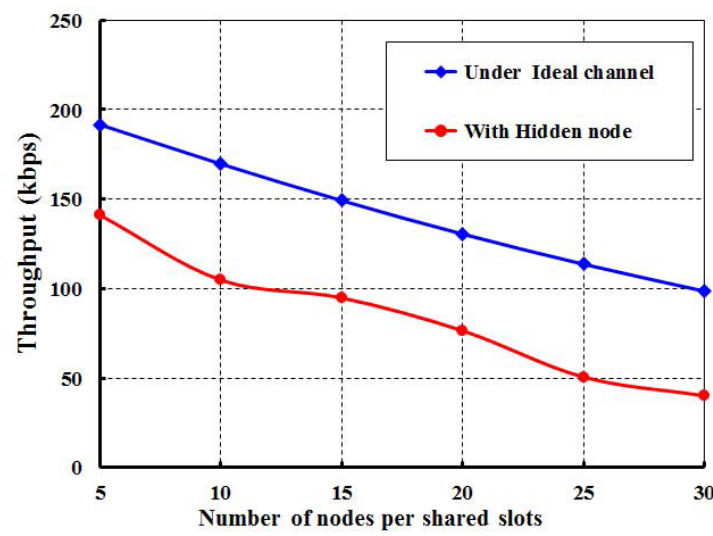
Figure 8. Throughput with and without hidden